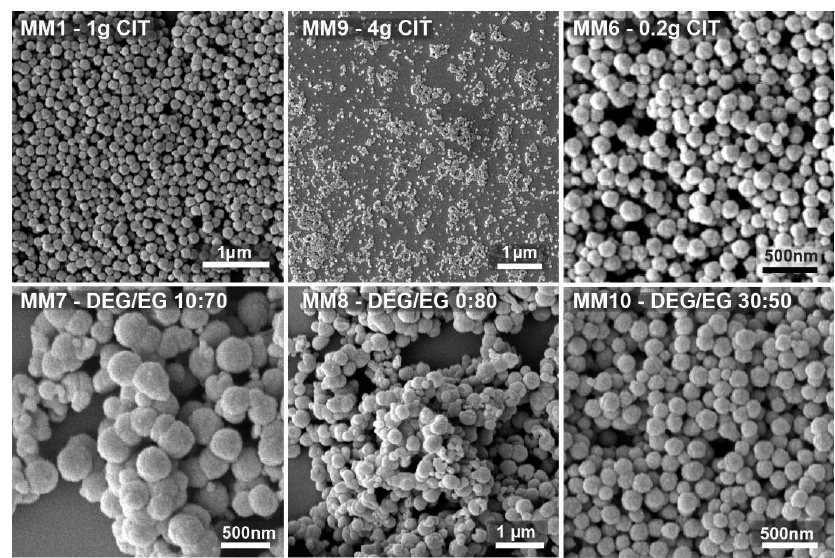
Figure 2. SEM images of the nanocrystal clusters prepared from the first set of experiments to check the system’s response to a change in quantities of tribasic citrate and diethylene glycol/ethylene glycol (DEG/EG) ratio, used to build up the model. The top three images show nanocrystal clusters prepared with a fixed ratio DEG/EG = 1 but with different citrate amounts. The bottom three images show the nanocrystal clusters prepared at a constant citrate amount equal to 1 g, but with different solvent ratios.